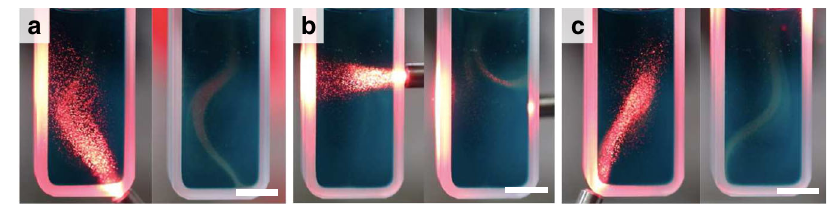
Fig. 6 Spatially precise convective fl ows. a – c (left panels) Irradiating one portion of the cuvette using a red LED light. a – c (right panels), convective fl ows that ensue due to irradiation. The same solution was used for all experiments depicted above (Supplementary